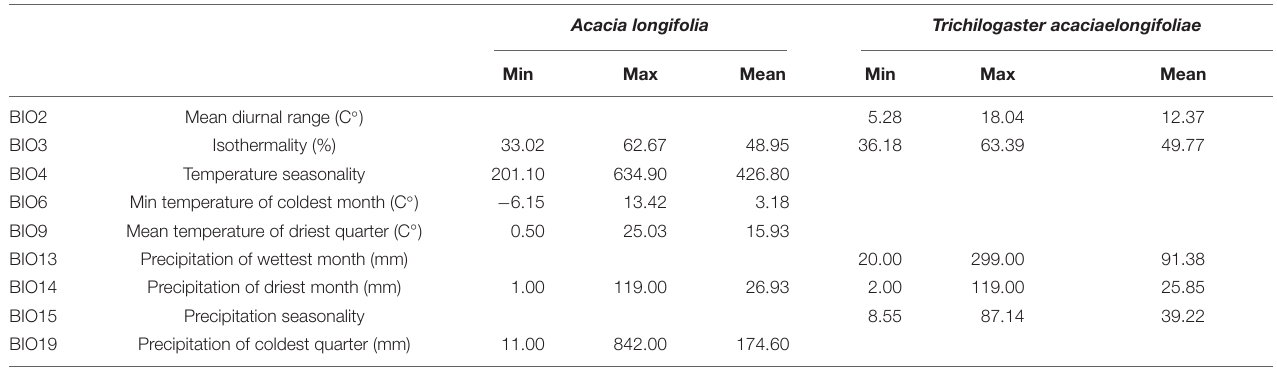
TABLE 1 | Variable ID and minimum, maximum, and mean values across model training areas for Acacia longifolia and Trichilogaster acaciaelongifoliae of ecogeographical variables used in model